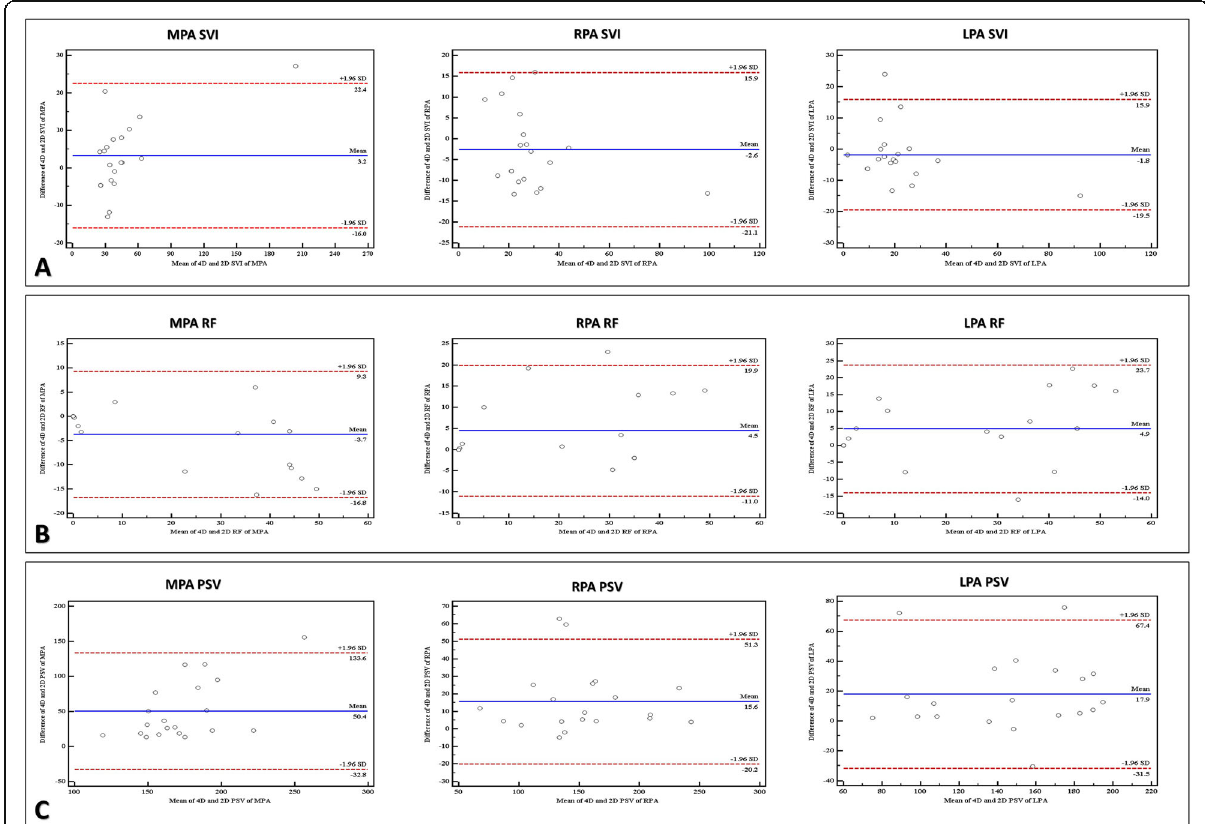
Fig. 5 Bland-Altman plots comparing between 4D-CMR and 2D-PC flow across the pulmonary arteries. The middle line represents the mean difference while the upper and lower lines represent the ± 1.96 standard deviation limit. The plots show the lines of equality between and 95% limits of agreement between the two studied methods for the SVI ( a ), RF ( b ), and PSV ( c ) across the pulmonary arteries. SVI: stroke volume, RF: regurgitation fraction, PSV: peak systolic velocity, MPA: main pulmonary artery, RPA: right pulmonary artery, LPA: left pulmonary